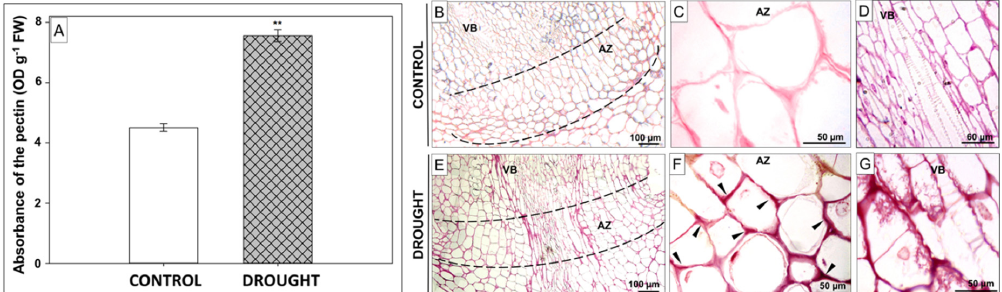
Figure 3. Drought causes changes in pectin distribution in floral abscission zone (AZ) of yellow lupine. Lupines were cultivated under water deficit conditions (25% WHC), while control plants were grown in the soil of optimal moisture (70% WHC). Sections of floral AZs were collected on the 48th day of cultivation. The total content of pectin based on pectin absorbance ( A ). Data are presented as averages ± SE ( n = 3). Significant di ff erences in the stressed plant in comparison to control plants are ** p < 0.01 (Student’s t -test). De-esterified pectin staining using Ruthenium red in the control AZ ( B – D ) and drought-stressed ( E – G ). AZ area is marked by the black dotted line ( B , E ). Arrowheads indicate the place of de-esterified pectin accumulation. Abbreviation: VB—vascular bundles. Bars are given in each image.